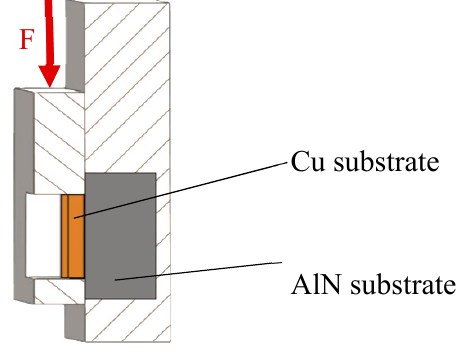
Figure 5. Scheme of shear strength measurement.